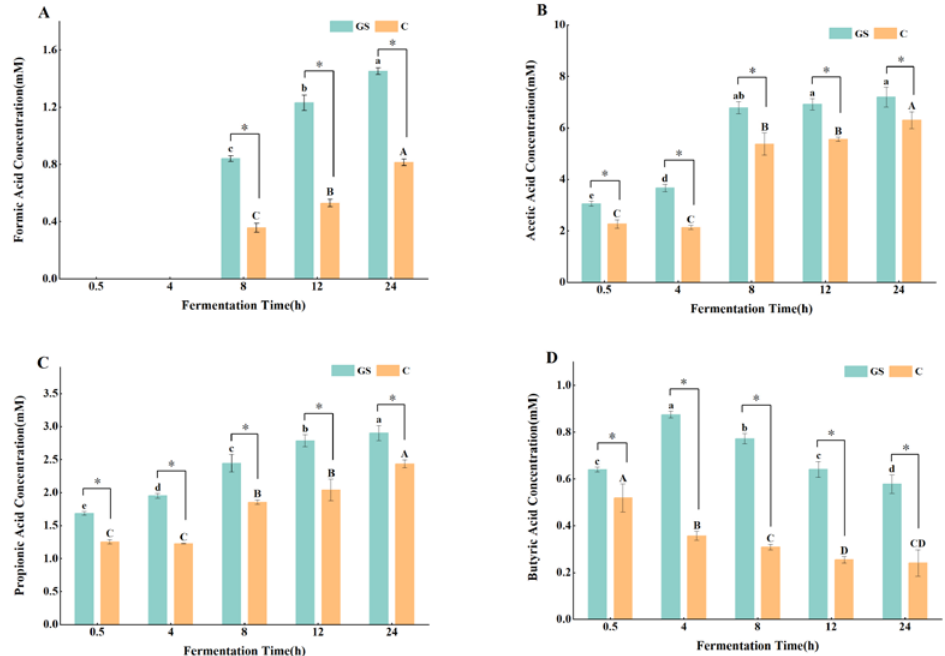
Figure 9. Change of SCFAs concentration during in vitro fermentation. ( A ) Formic acid concentration; ( B ) Acetic acid concentration; ( C ) Propionic acid concentration; ( D ) Butyric acid concentration. Means with different letters in figures were significantly different at p < 0.05, * p < 0.05.